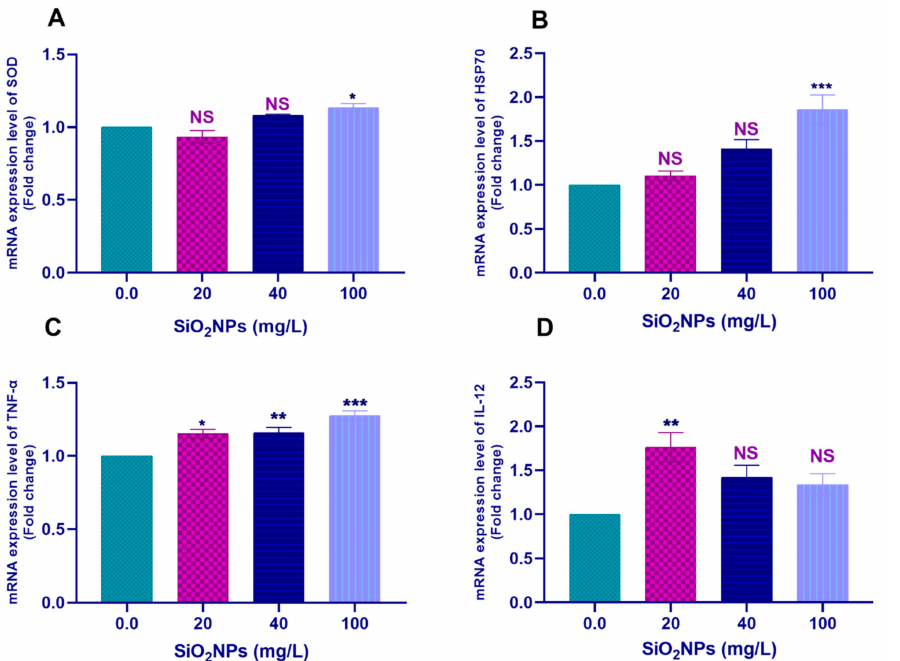
Figure 4. Transcription profile of the ( A ) SOD , ( B ) HSP70 , ( C ) TNF- α , and ( D ) IL-12 genes in the hepatic tissues of Nile tilapia juveniles after exposure to different concentrations of SiO 2 NPs (0.0, 20, 40, and 100 mg/L) for 21 days. The values are expressed as mean ± SEM ( n = 9). Asterisks (*) ( p < 0.05), (**) ( p < 0.01), and (***) ( p < 0.001) indicate significant differences between the exposure groups compared with the control group. NS indicates non-significant differences.